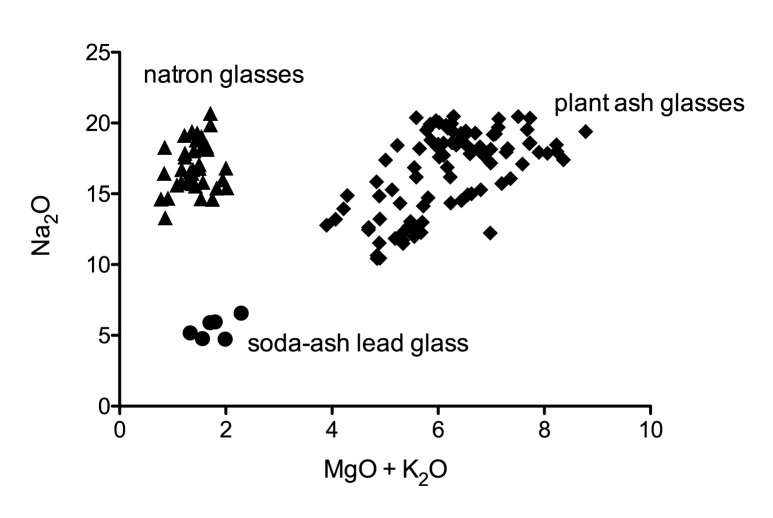
Soda concentrations versus the sum of potash and magnesia of all glasses from Ciudad de Vascos.The three main glass types are easily distinguished based on the sum of the alkali and alkaline earth components MgO and K2O.